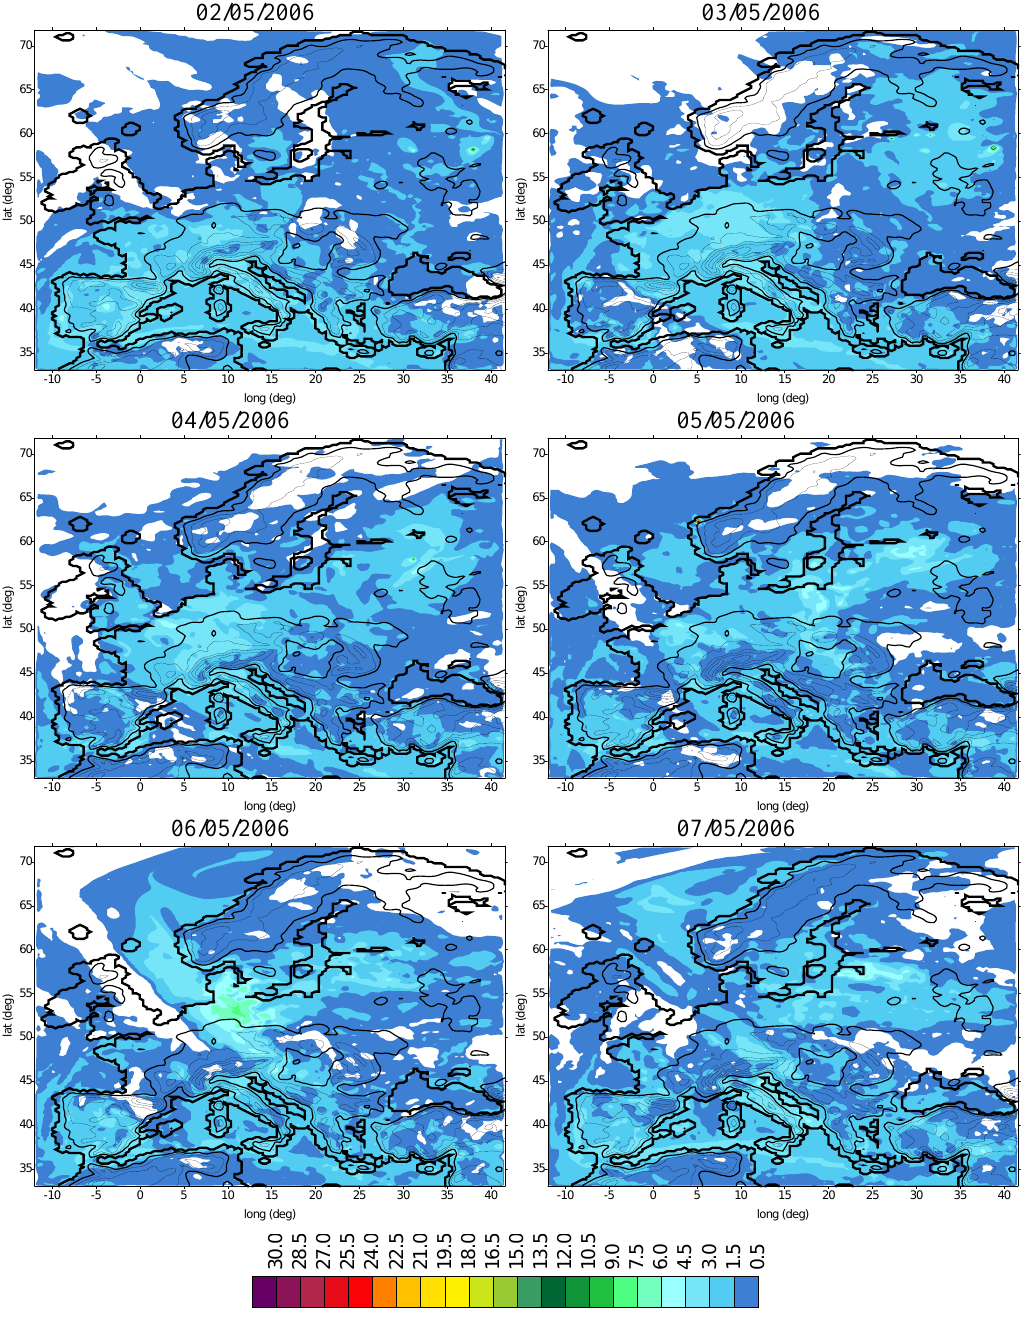
Fig. 6. Integrated hourly VOC (CO and CH 4 are included) – OH oxidation rates (ppbh − 1 ) at the hour when the peak O 3 concentration occurred during the period 2–7 May